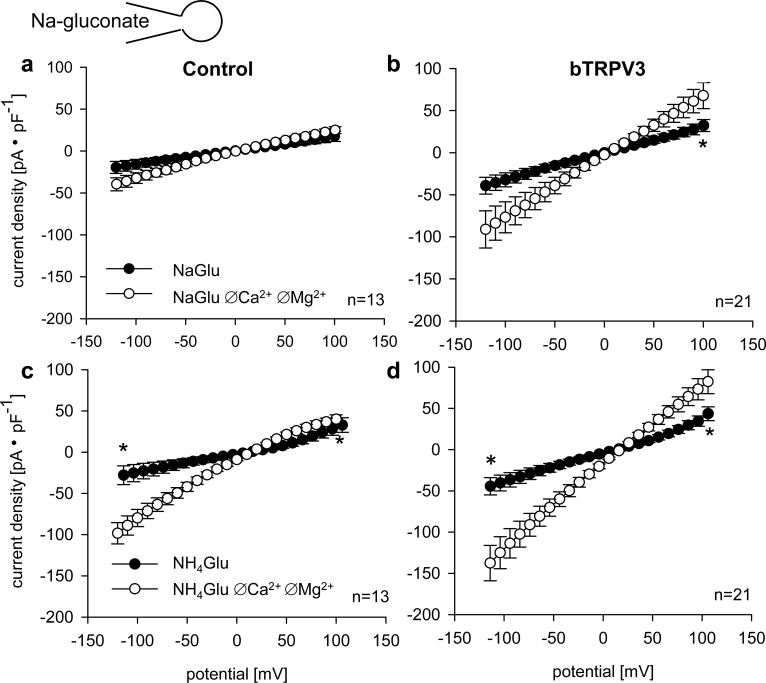
Current-voltage plots of whole cell measurements from Fig 2.The figures give the mean current values (± SEM) of control cells (a, c) and cells expressing bTRPV3 (b, d) in Na-gluconate (a, b) or NH4-gluconate (c, d) bath solutions with (●) and without (○) divalent cations, as indicated. (*: p < 0.05, tested for −100 mV and +100 mV).